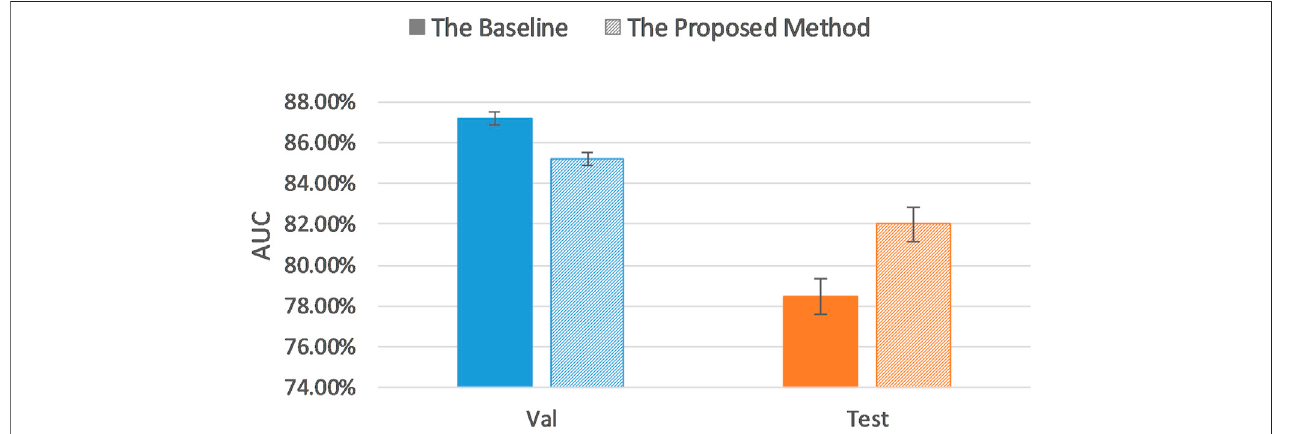
FIGURE 6 | Comparison of AUC results of the proposed method and baseline on the balanced dataset.